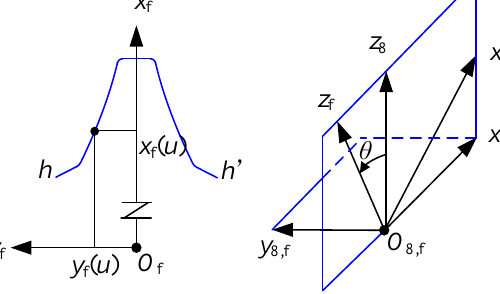
Figure 4. Wheel surface swept by its axial profile.